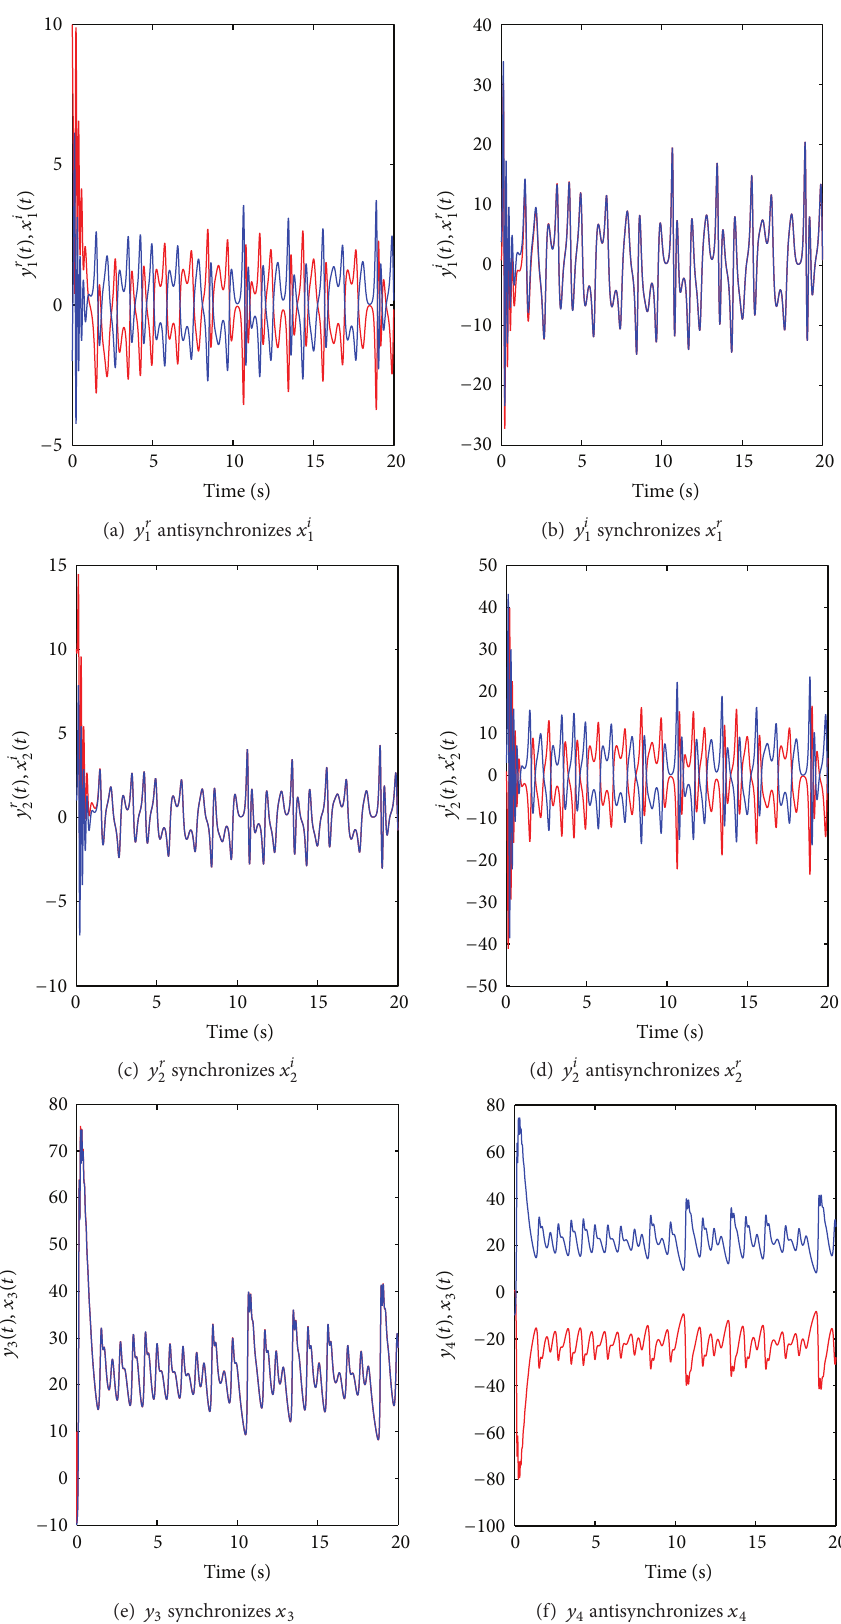
Figure 8: Increased order synchronization—CMHPS between 3-dimensional complex chaotic L¨u drive system (37) (blue line) and 4- dimensional complex hyperchaotic Dadras response system (39) (red line) with the controller